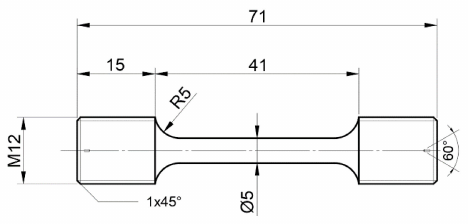
Figure 1. Uniaxial tensile tests specimen (unit: mm)